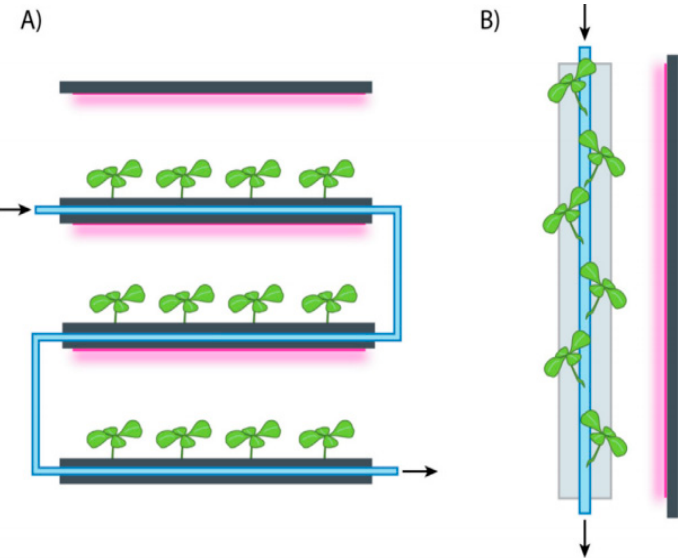
Figure 2. Structure of the hydroponics vertical farm ( A ) Nutrient film technique. Each tray has LED lighting above it. ( B ) Drip irrigation system. The column is dripped with nutrient water. This device can either allow for more natural daylight or be illuminated from the side by LEDs. Reprinted with permission from ref. [30]. Copyright 2021 Elsevier.